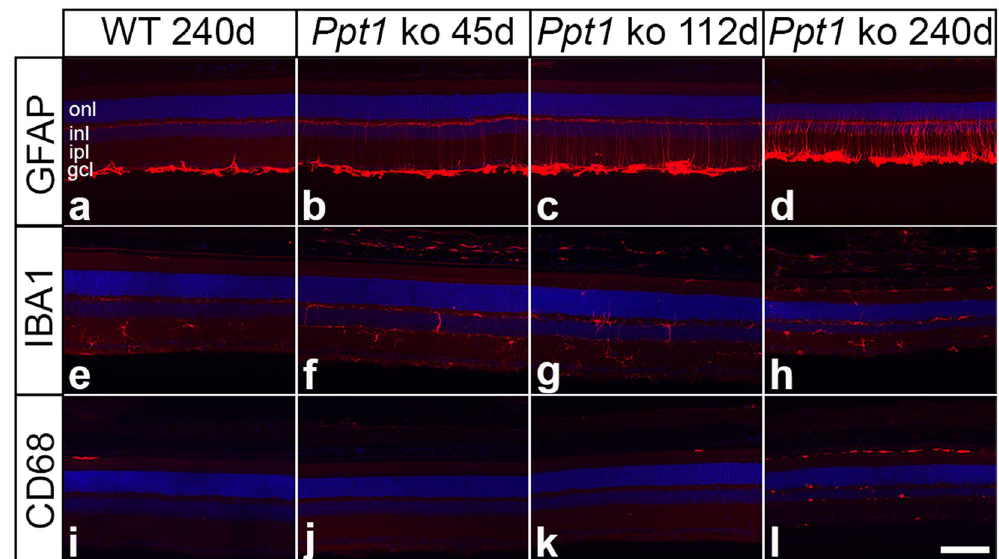
Figure 1. Reactive astrogliosis and microgliosis in PPT1-deficient retinas. Expression of GFAP, IBA1 and CD68 in wild-type and Ppt1 ko retinas. Note the presence of some faintly GFAP-positive Müller cells in mutant retinas at P45 (b ). The number of positive Müller cells and expression levels of GFAP increased considerably with increasing age of the mutants ( c,d ). IBA-1-positive microglial cells were restricted to the inner retina of mutant mice at P45 ( f ), but became detectable in the outer retina and subretinal space at P112 ( g ) and P240 ( h ). A few CD68-positive cells were present in the outer retina of 112-day-old mutants ( k ), and their number was considerably increased in P240 Ppt1 ko retina, particularly in the subretinal space ( l ). Immunostainings of 240-day-old wild-type retinas are shown for comparison ( a,e,i ). gcl: ganglion cell layer; inl: inner nuclear layer; ipl: inner plexiform layer; onl: outer nuclear layer. Scale bar in ( l ) (for a–l ): 100 µ m.